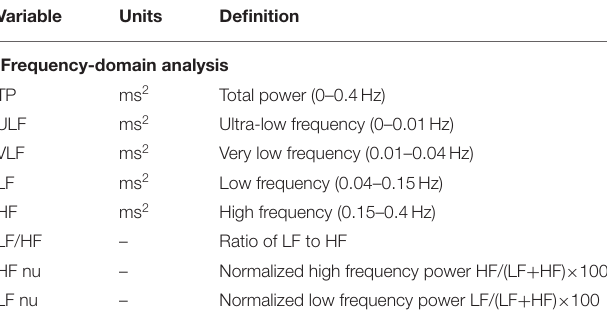
TABLE 2 | Selected frequency-domain HRV